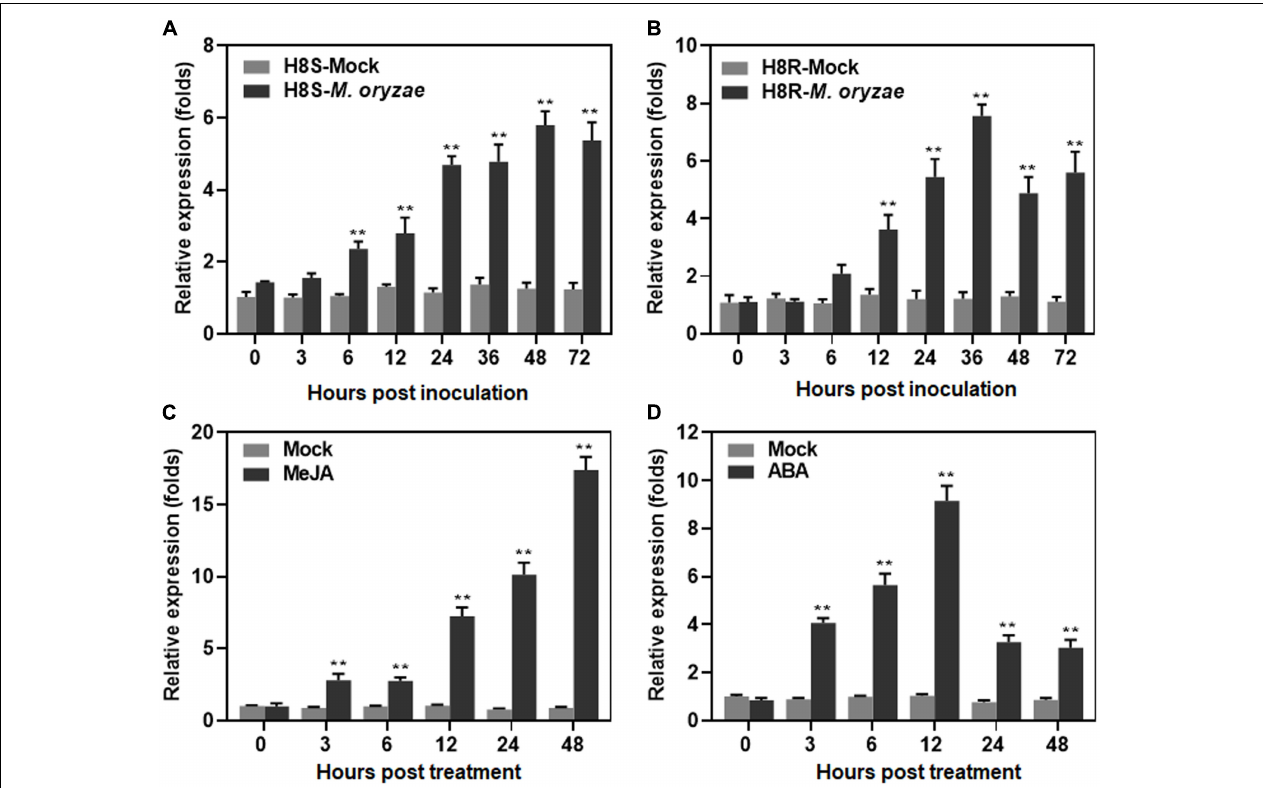
FIGURE 1 | Responsiveness of ONAC096 to M. oryzae and defense signaling hormones. (A,B) Expression changes of ONAC096 in compatible (A) and incompatible (B) interactions between rice and M. oryzae . Three-week-old rice seedlings of H8S (compatible interaction) and H8R (incompatible interaction) were inoculated by foliar spraying with spore suspension of M. oryzae (2 × 10 5 spores/mL) or equal water as mock controls. (C,D) Expression changes of ONAC096 after treatment with defense signaling hormones ABA (C) or JA (D) . Two-week-old rice seedlings of cv. ZH11 were treated by foliar spraying with 100 µ M ABA, 100 µ M JA or equal water as mock controls. Leaf samples were collected at indicated time points after M. oryzae inoculation (A,B) or hormone treatment (C,D) . Relative expression levels of ONAC096 as compared to those of the 18S rRNA gene are presented as the means ± SE from three independent experiments. Asterisks indicate significant difference ( p < 0.01, Student’s t test) in comparison to mock inoculation (A,B) or mock treatment (C,D) at each time